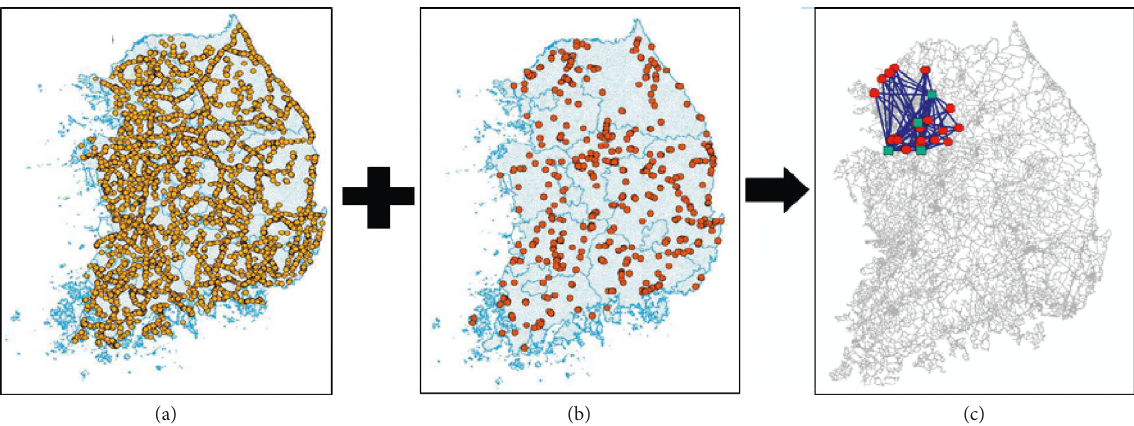
Figure 10: GIS analysis. (a) Bridges; (b) fire stations; (c) OD cost matrix analysis.